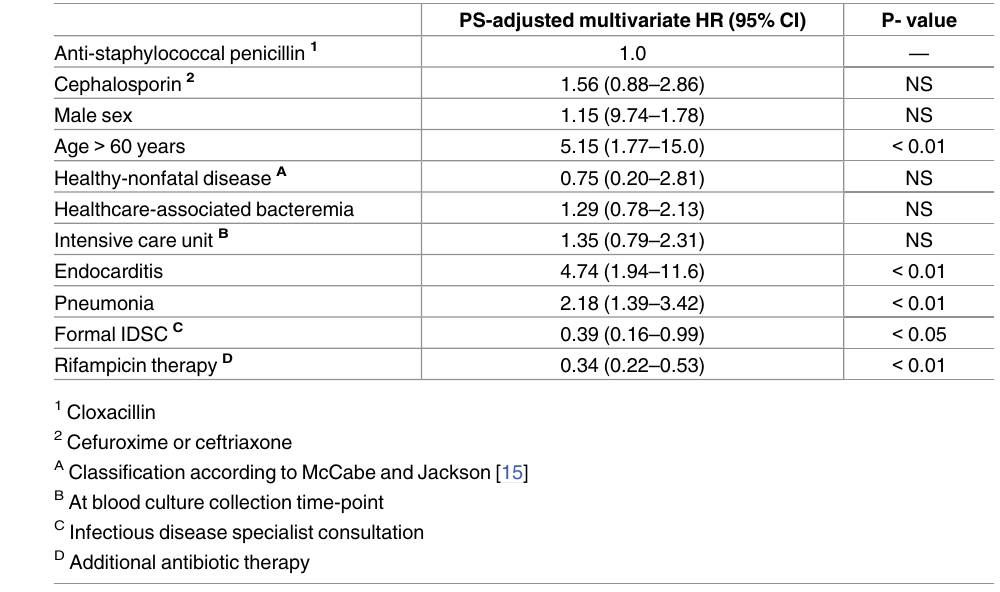
Table 4. Propensity-score adjusted Cox proportional regression analysis for 90-day mortality among 580 patients with methicillin-sensitive Staphylococcus aureus bacteremia receiving either anti-staph- ylococcal penicillin (n = 92) or cephalosporin (n = 488) as first week antimicrobial